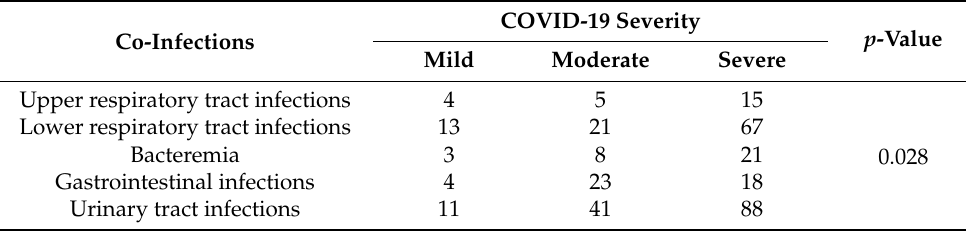
Table 5. Distribution of co-infections among COVID-19 patients admitted in SICUs.